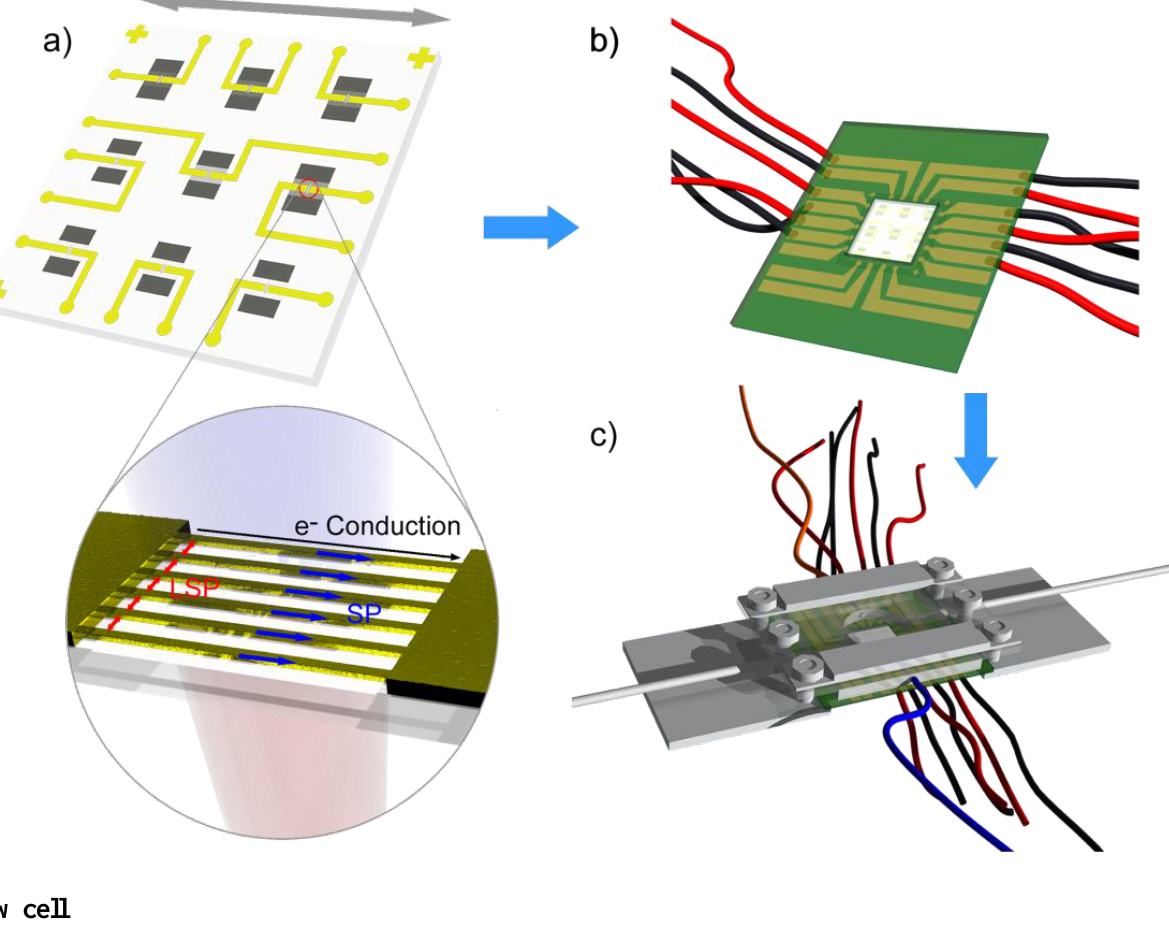
Figure A4. An illustration of the concept of an array of nanowire sub-arrays and microfabrication configuration. Image (a) shows multiple nanowire regions on a glass chip, where each connected region is itself an array of gold nanowires connected in parallel between gold contacts, as shown in image (a) . The integration of the optical chip into a PCB is shown in (b) , while (c) illustrates the entire chip’s integration into a transparent electrochemical flow cell. Also illustrate are the several sensing phenomena of this combined system: Sensing with surface plasmons (possible propagation along the wire axis), localized plasmons (confined to the perpendicular plane and the coupling between nanowire gaps), and electrical signals through the nanowires between the contact